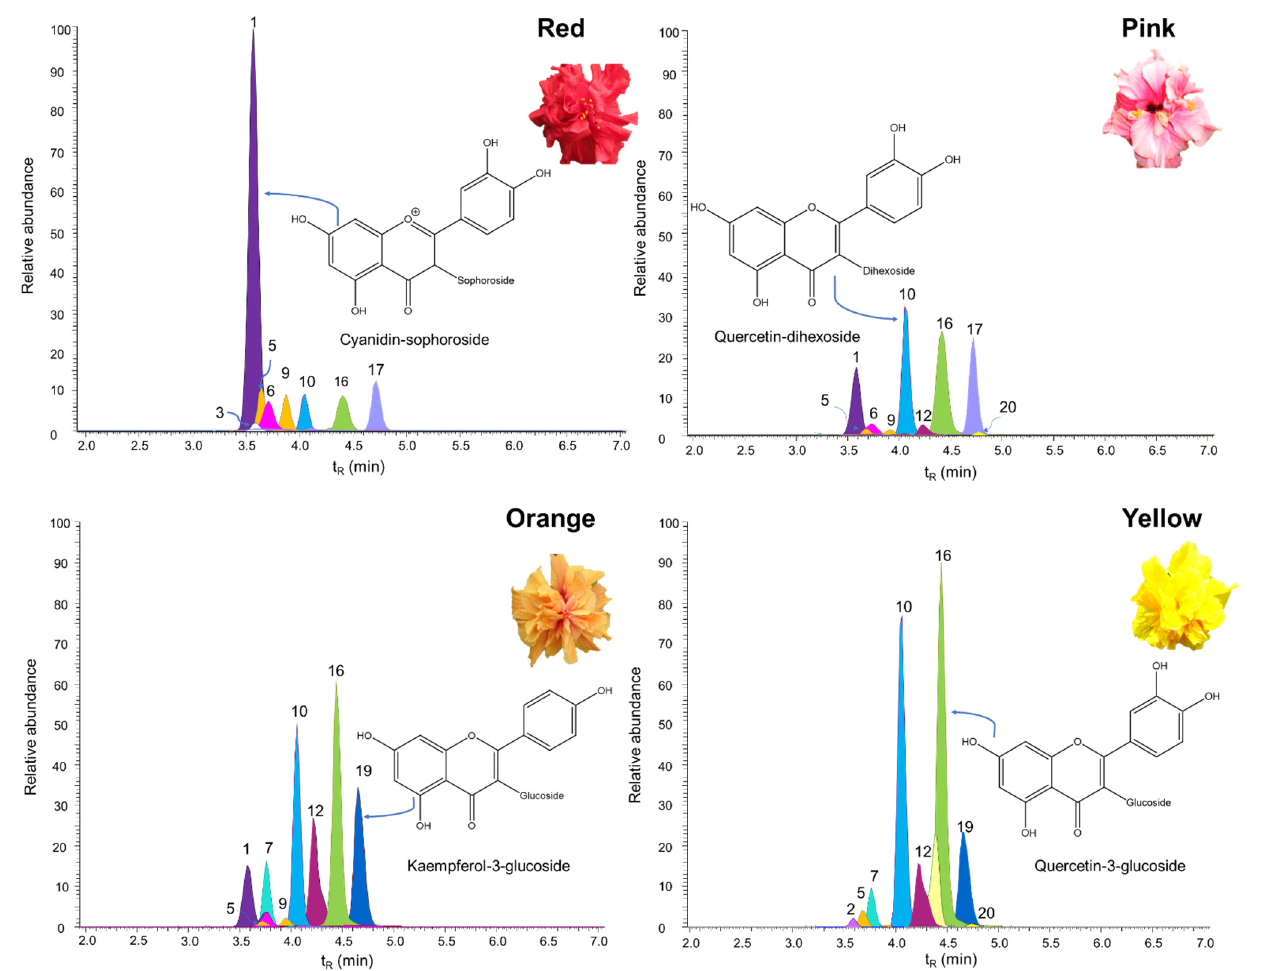
Figure 2. Chromatographic profiles obtained by LC/MS of the hydroalcoholic extracts of four H . rosa ‐ sinensis cultivars. Chromatographic peak identification appears in Table 1.